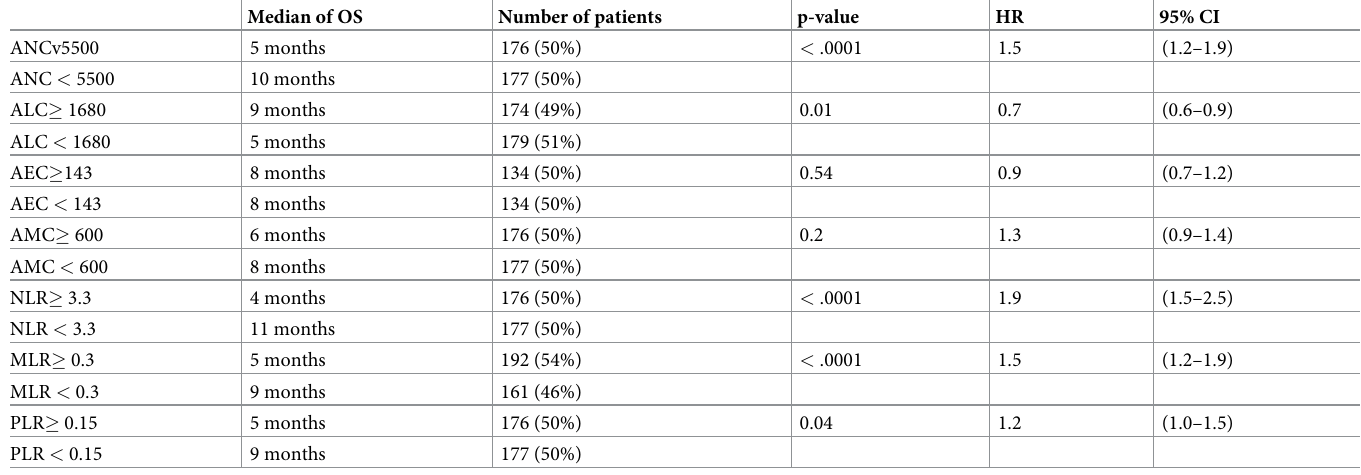
Table 5. The results of the survival